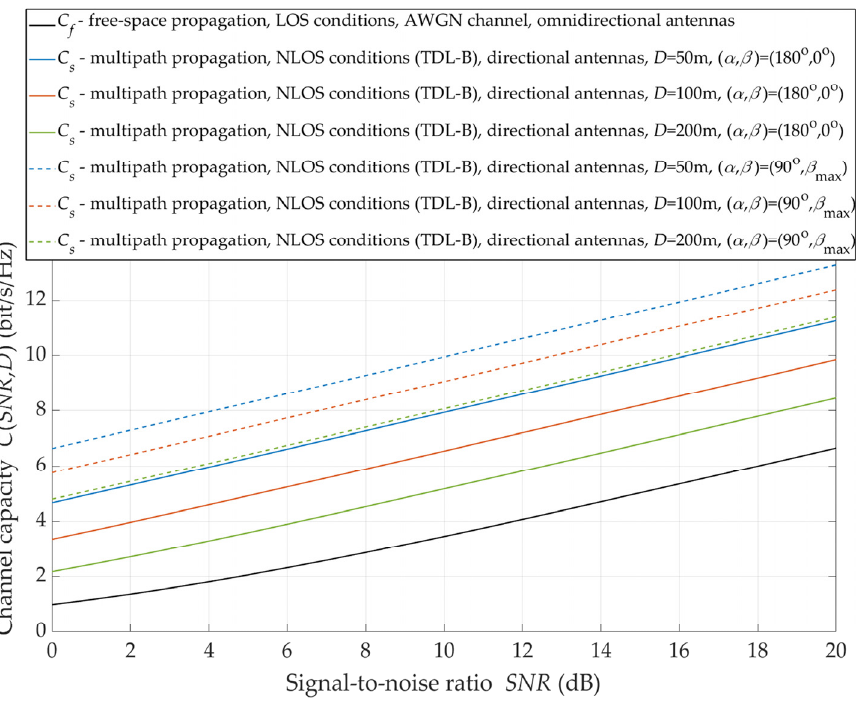
Figure 12. Capacity versus SNR for β max under NLOS conditions.